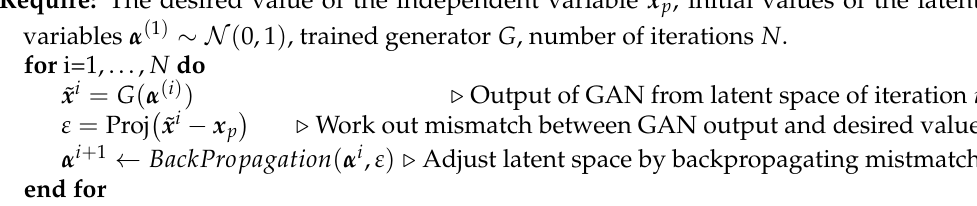
Algorithm 1 Prediction Function. Built to be used in conjunction with the trained WGAN, to constrain the independent variable of the regression